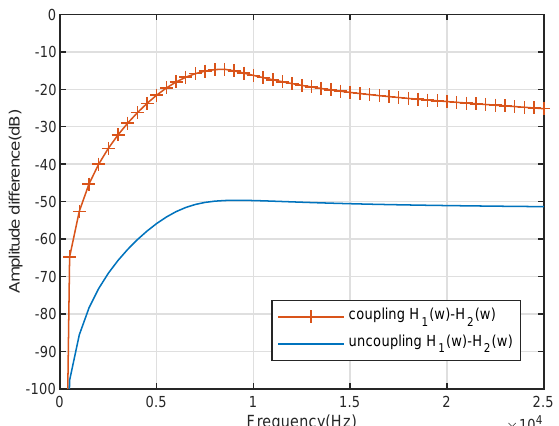
Figure 3. Amplitude difference of the Ormia ochracea ’s two ears with coupling and uncoupling.